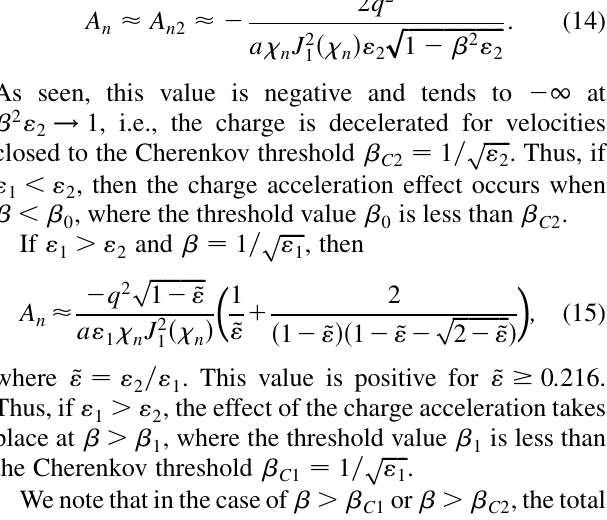
p ffiffiffiffiffiffiffiffiffiffiffiffiffiffiffiffiffiffiffiffi 1 (cid:3) (cid:1) 2 " and 1 p ffiffiffiffiffiffiffiffiffiffiffiffiffiffiffiffiffiffiffiffi 1 (cid:3) (cid:1) 2 " (Fig. 2). Using the Fig. 3. We note that the dependences of A 2